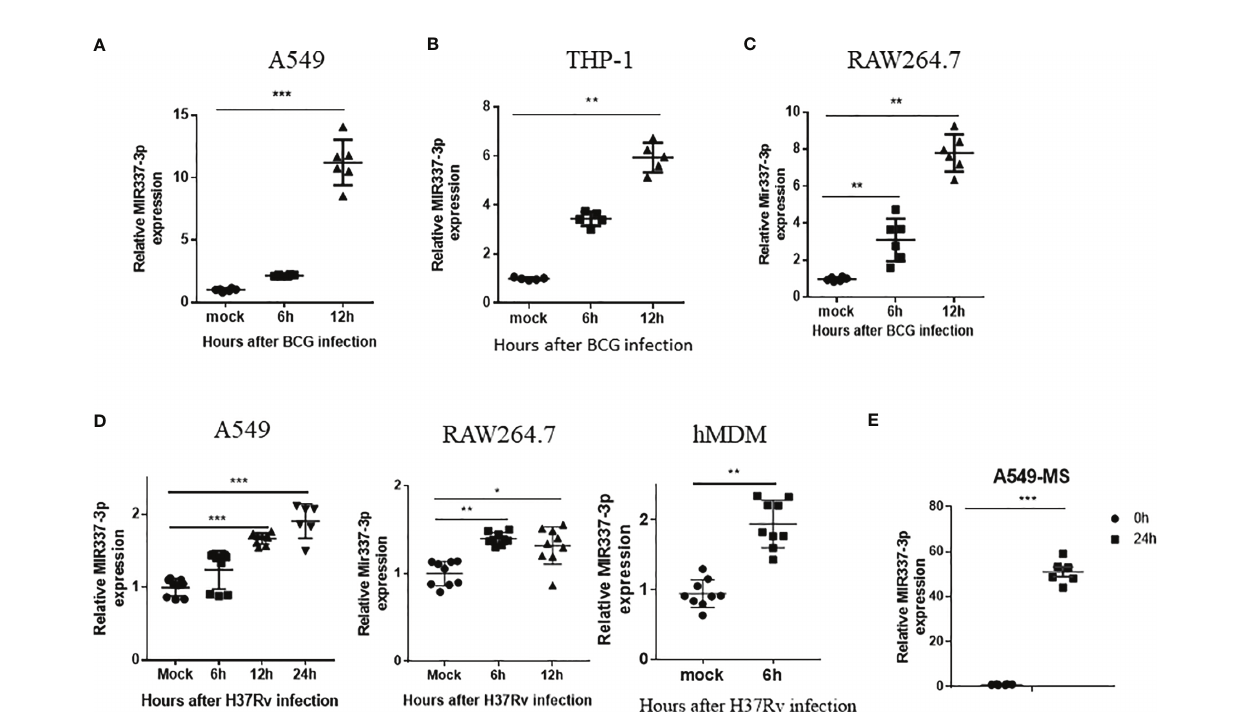
FIGURE 2 | High-level MIR337-3p/Mir337-3p expression was induced by mycobacterial infection in cellular models. (A – C) show that BCG infection induced a signi fi cantly higher expression of MIR337-3p/Mir337-3p in lung alveolar epithelial A549 cells (A) and macrophages THP-1 (B) and RAW264.7 (C) . Cells were infected by M. bovis BCG (MOI = 10) for 0, 6, and 12 h, respectively. The expression of MIR337-3p/Mir337-3p was measured by qPCR. (D) shows that the virulent strain of M. tuberculosis H37Rv infection (MOI = 2) enhanced MIR337-3p expression in human epithelial A549 cells, mouse macrophage RAW264.7, and human monocyte- derived macrophages (hMDMs). (E) shows that fast-growing M. smegmatis (MS) infection also induced high-level MIR337-3p expression in A549 cells. Data are shown as mean ± standard errors. *P < 0.05, **P < 0.01, and ***P <